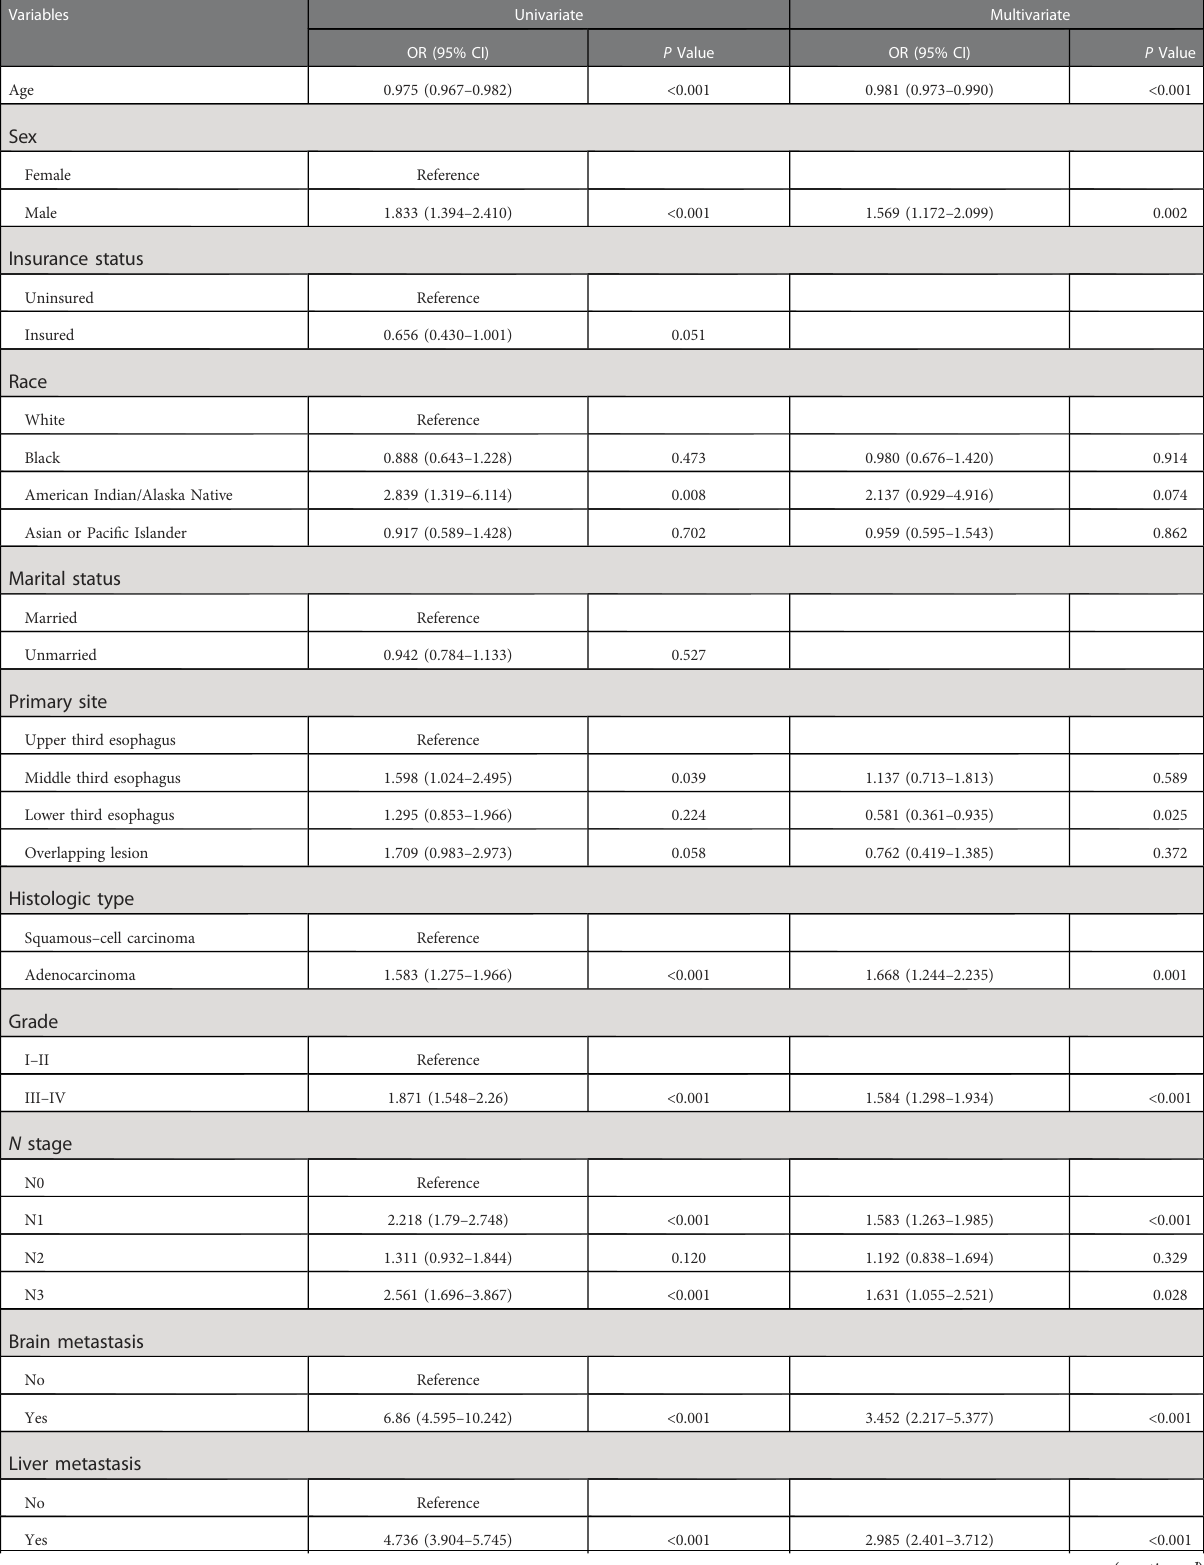
TABLE 3 Univariate and multivariate logistic regression analyses in esophageal cancer patients with bone metastasis in the training